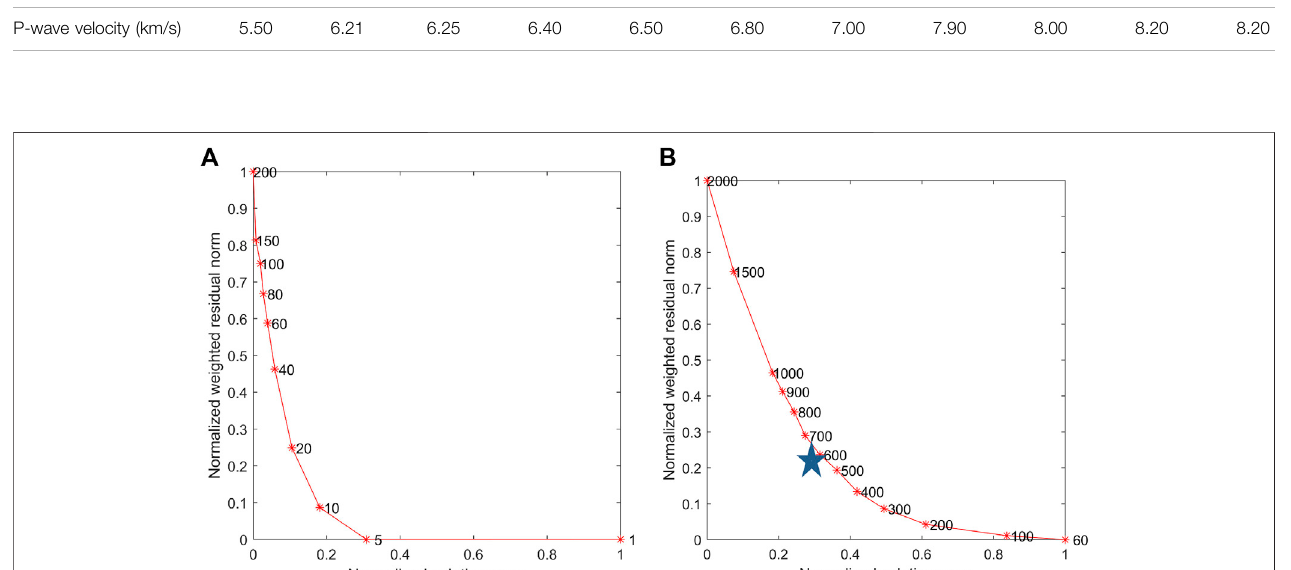
Frontiers in Earth Science |